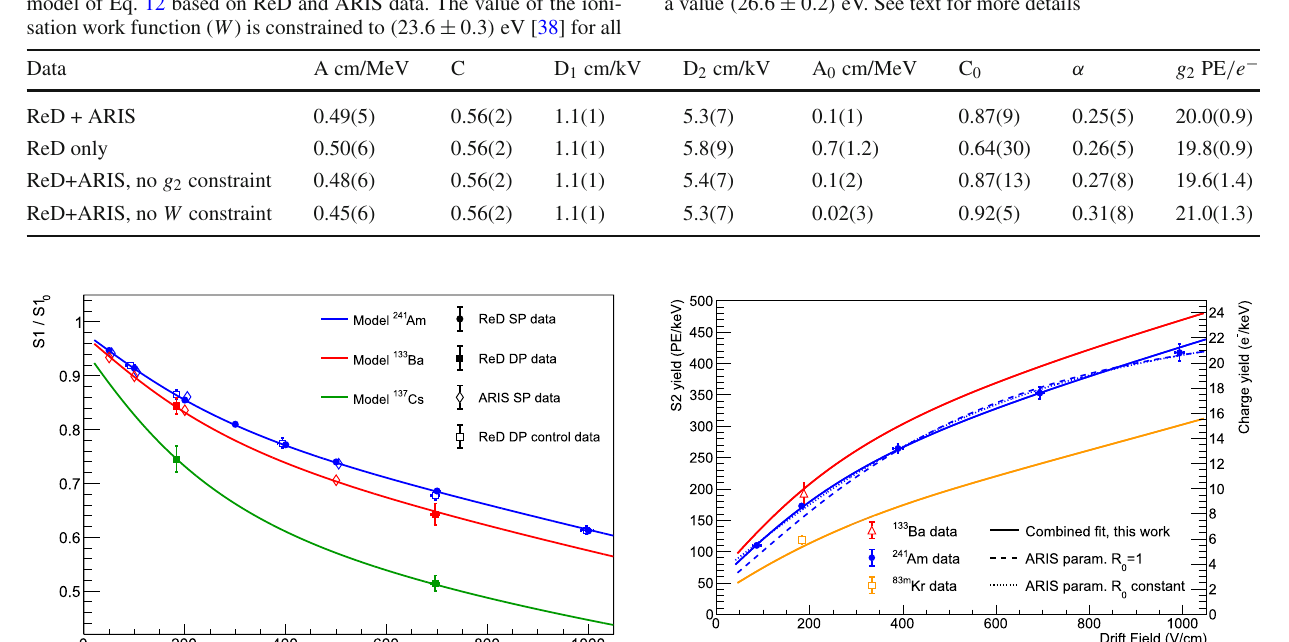
fits, except for that labeled ‘no W constraint’, for which the fit returns a value ( 26 . 6 ± 0 . 2 ) eV. See text for more details